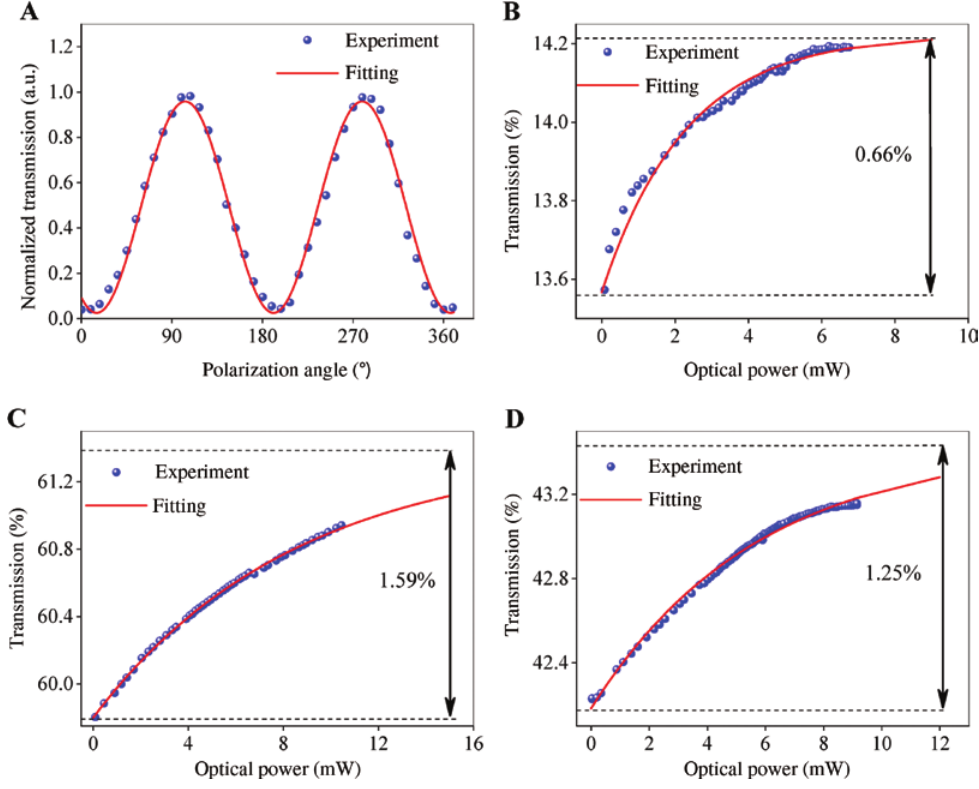
Figure 2: Polarization dependence and nonlinear optical response of PbSe SAs. (A) Transmitted power of DSF-PbSe vs. the angle of the linearly polarized light. The Y-axis has been normalized by dividing by the maximum transmitted power. Nonlinear transmission of (B) DSF-PbSe SA, (C) FF-PbSe SA, and (D) PVA-PbSe SA.